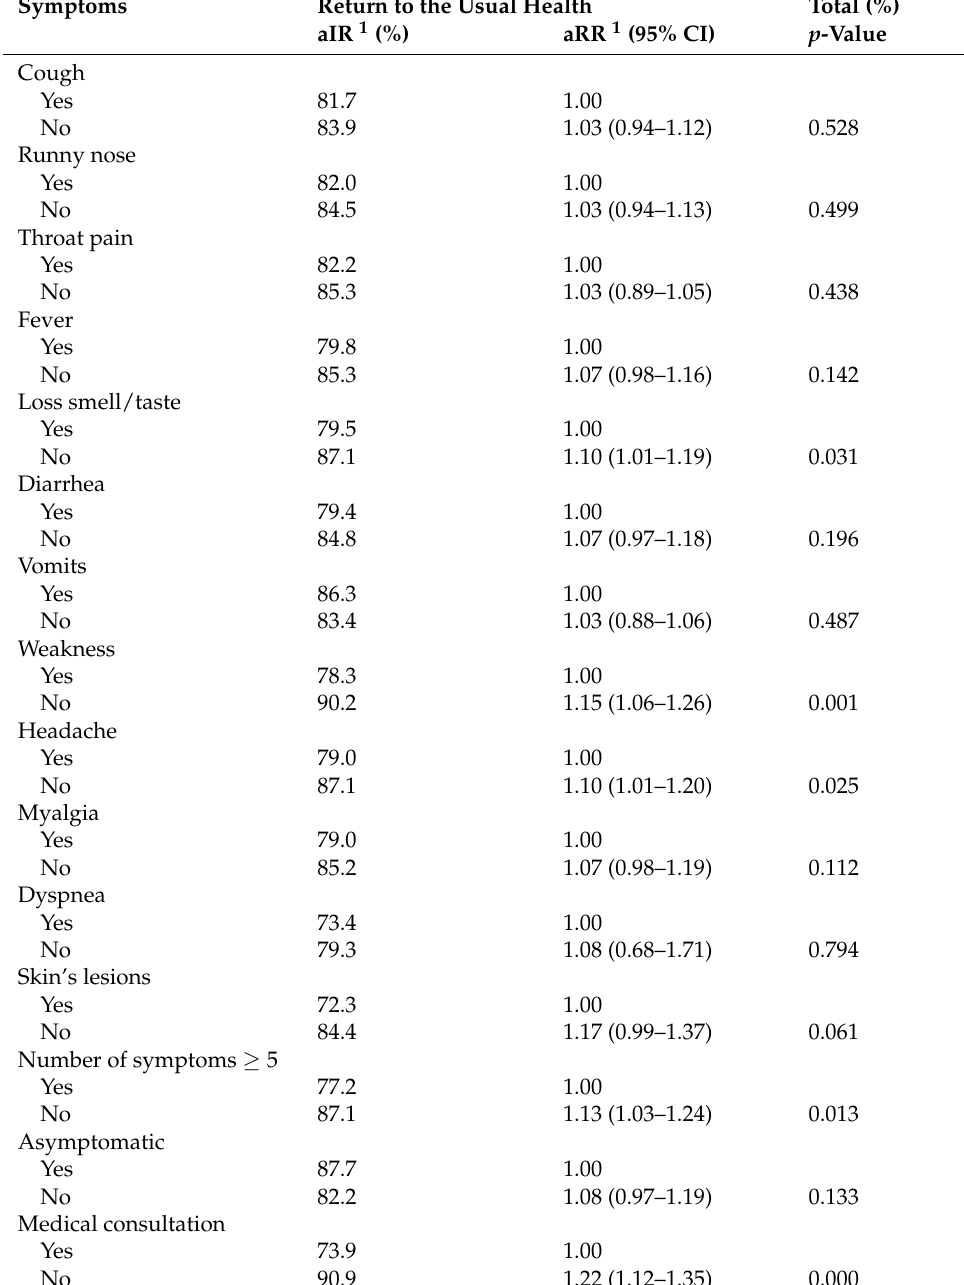
Table 5. Symptoms of acute COVID-19 illness and return to the usual health by adjusted incidence ratio (aIR) and adjusted relative risk (aRR). Borriana COVID-19 cohort 2020. Symptoms Return to the Usual Health Total (%) aIR 1 (%) aRR 1 (95% CI) p -Value Cough Yes 81.7 1.00 83.9